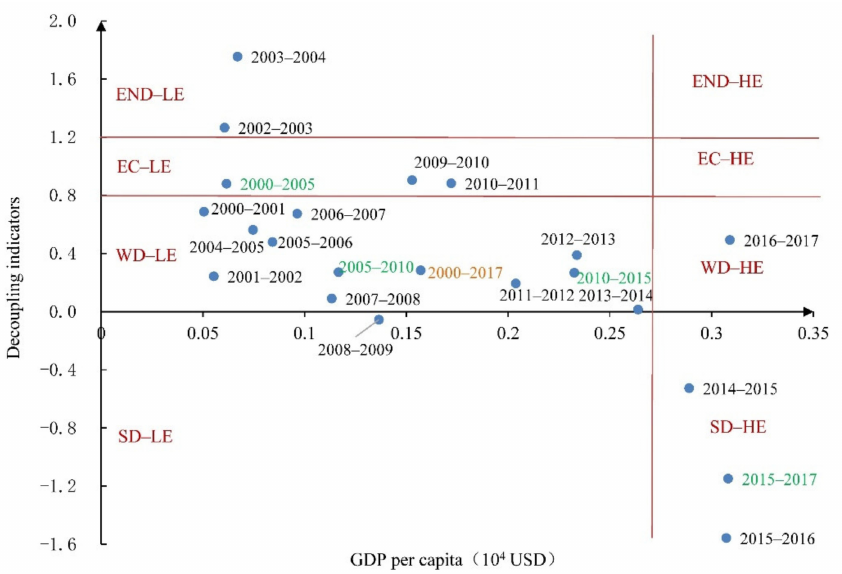
Figure 9. Results of two-dimensional decoupling analysis between economic development